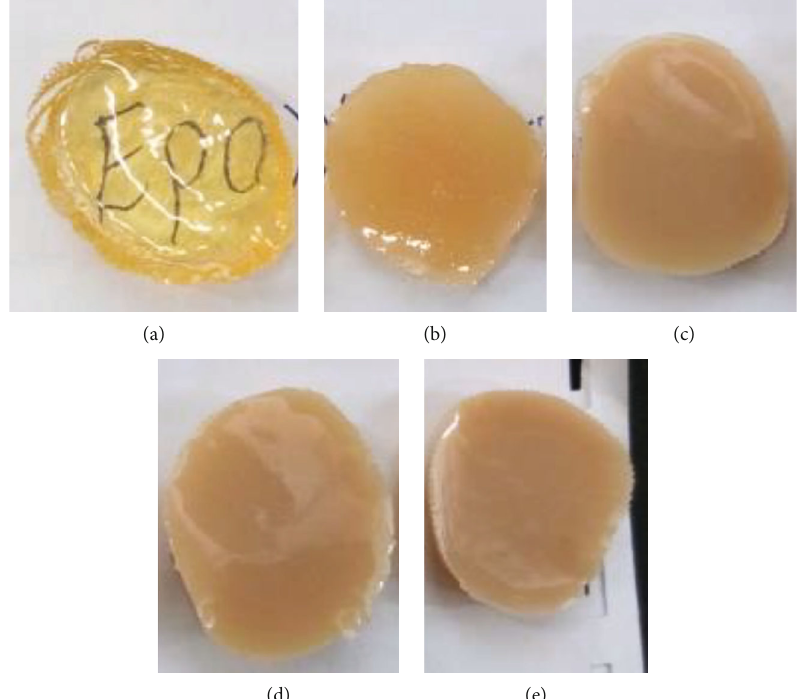
Figure 4: Shows the visual images of the epoxy-MK composite: (a) EP0, (b) EP1, (c) EP3, (d) EP5, and (e) EP7 (reduction in transparency due to the addition of MK fi llers is shown and visually